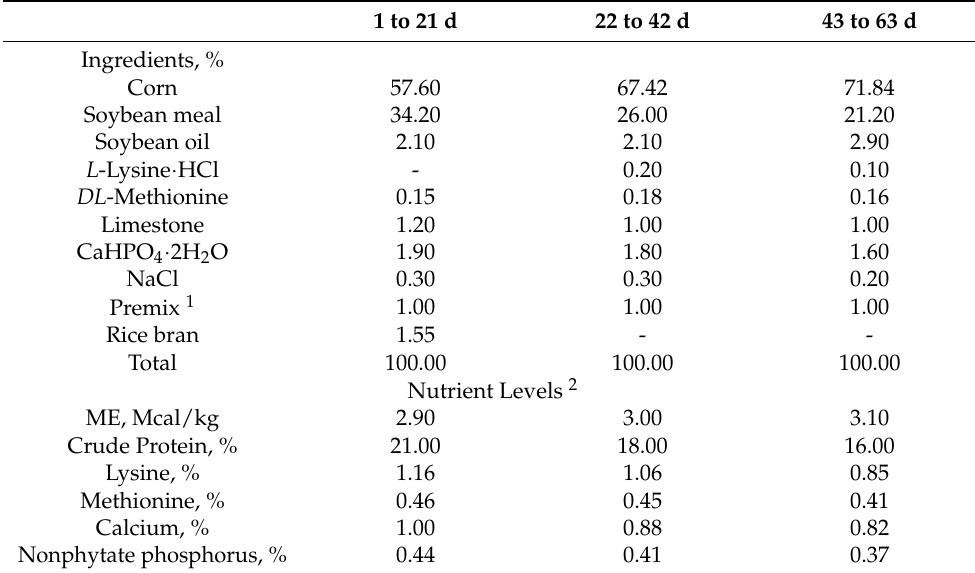
Table 1. Composition and nutrient levels of the basal